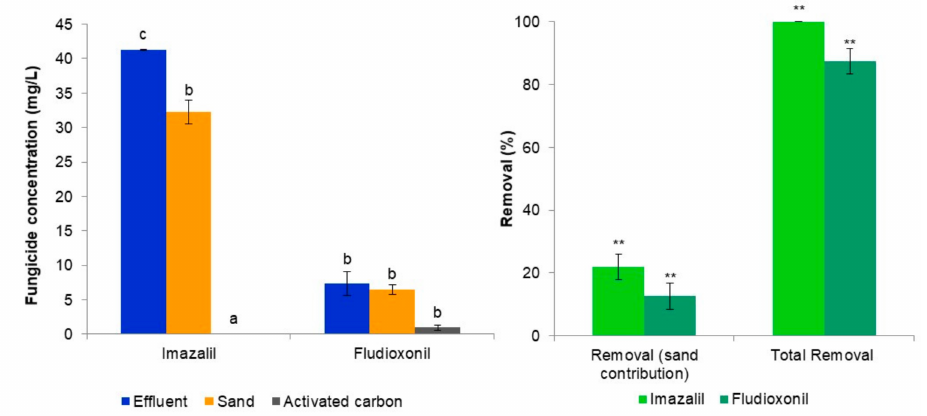
Figure 5. Imazalil and fludioxonil concentrations ( left graph) and their removal efficiencies ( right graph) during processing of the biologically treated fungicide-containing effluent through the sand filter and the activated carbon adsorption column system. For each pesticide, bars designated by the same letter are not statistically significant at the 5% level. Asterisks indicate statistically significant differences at the 1% level regarding fungicide removal efficiencies after the sand filtration and sand filtration-activated carbon adsorption